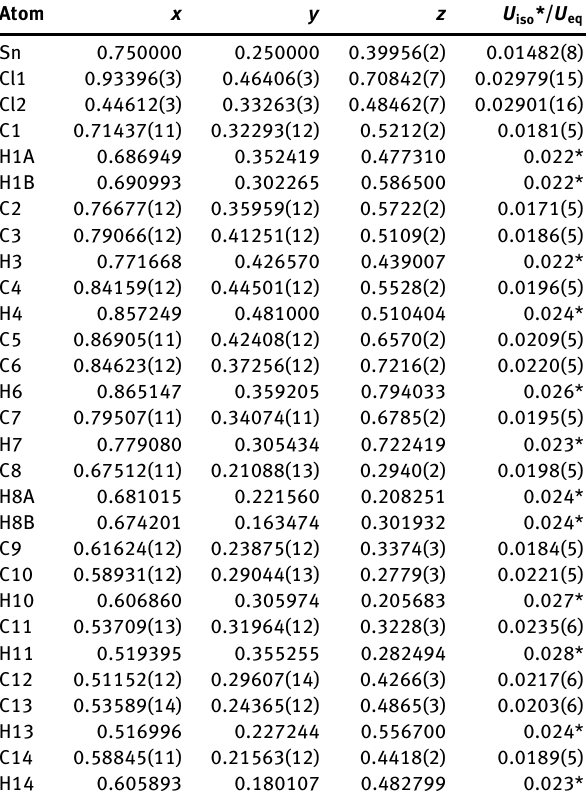
Table 2: Fractional atomic coordinates and isotropic or equivalent isotropic displacement parameters (Å 2